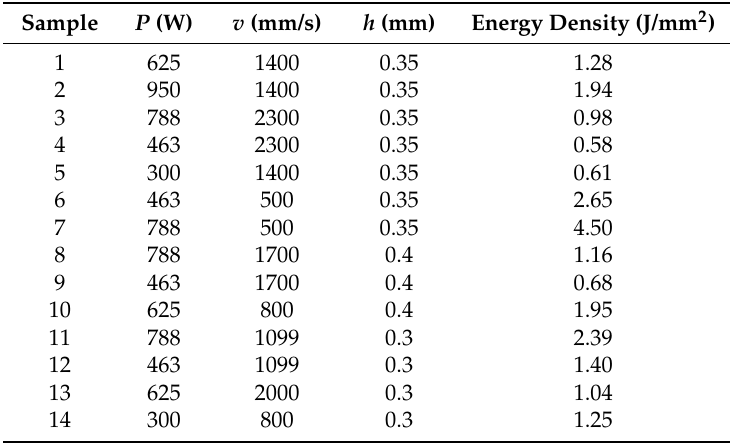
Table 1. Chemical composition of AlSi10Mg alloy by inductively coupled plasma atomic emission spectrometry (ICP-AES) [10]. Si Mg Cu Fe Zn Al wt.% wt.% wt.% wt.% wt.% wt.% 10.6 0.45 <0.01 Bal. Table 2. Parameters for selective laser melting (SLM) based on Doehlert design. Sample P (W) v (mm/s) h (mm) Energy Density (J/mm 2